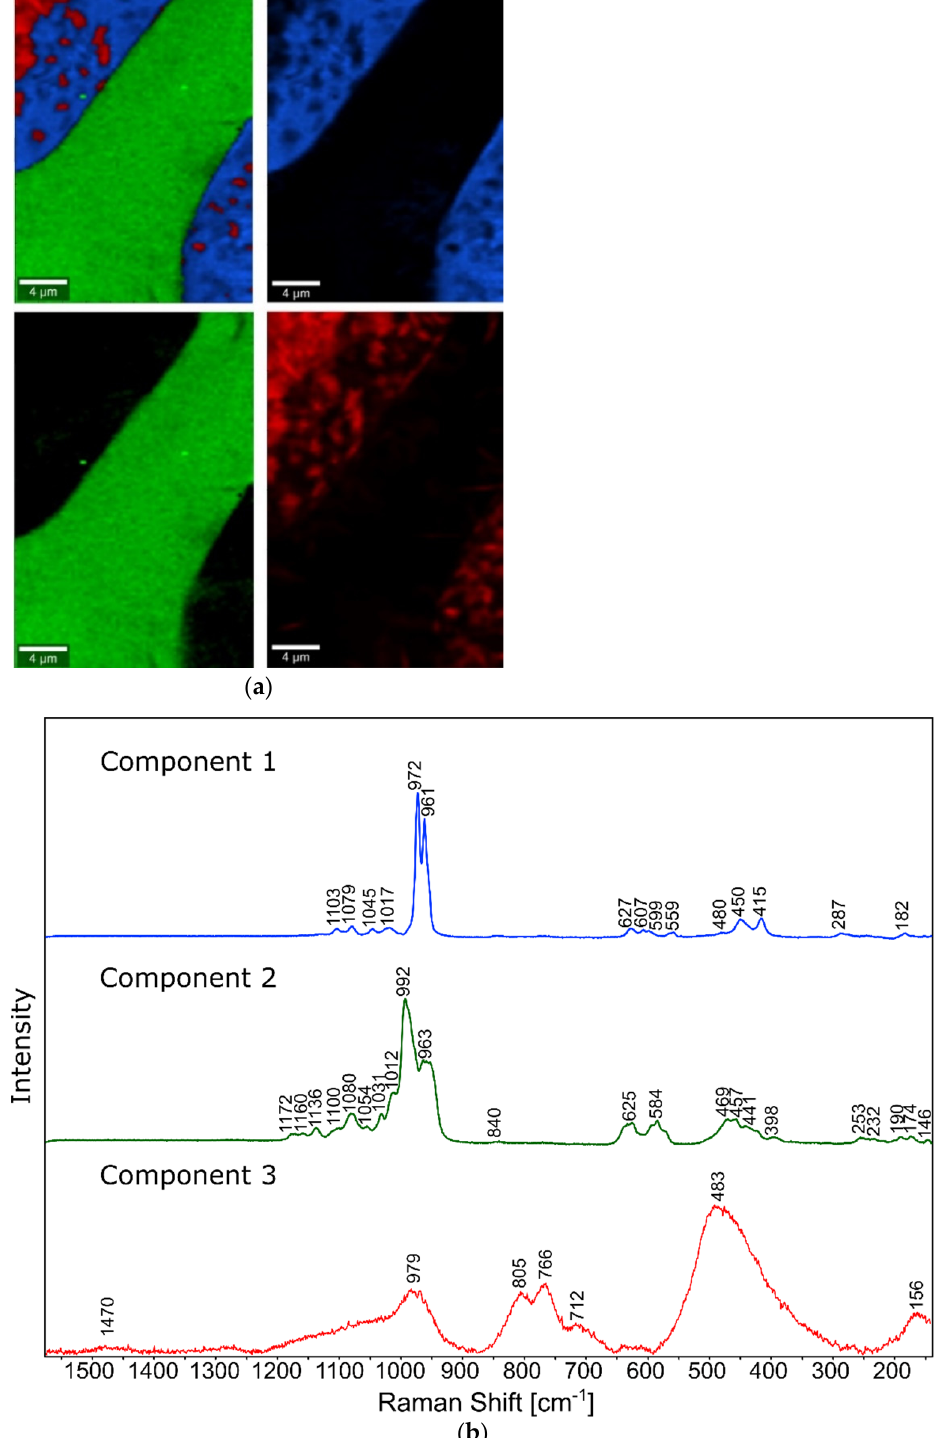
Figure 10. Raman measurements of sample 20B_710. ( a ) Raman images obtained from cluster analysis and ( b ) average Raman spectra from corresponding clusters: Component 1—Ca 9 MgK(PO 4 ) 7 -whitlockite structure type, Component 2—Mg 3 Ca 3 (PO 4 ) 4 -stanfieldite type, Component 3—glass matrix.